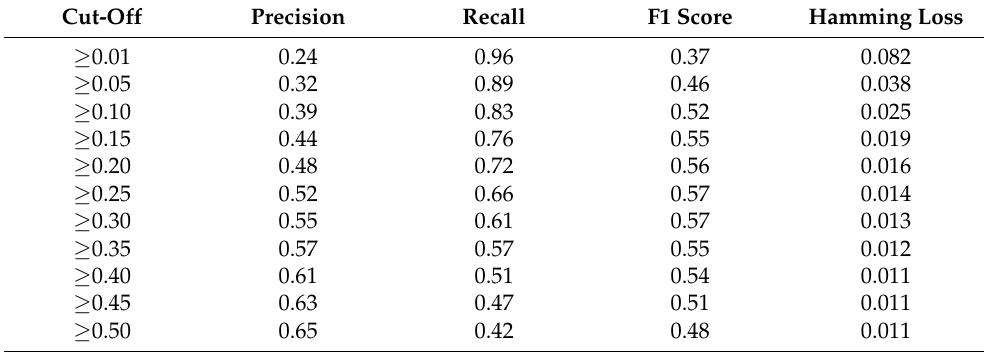
Table 1. The performance of DL model based on varying cut-offs for clinical laboratory test prediction.